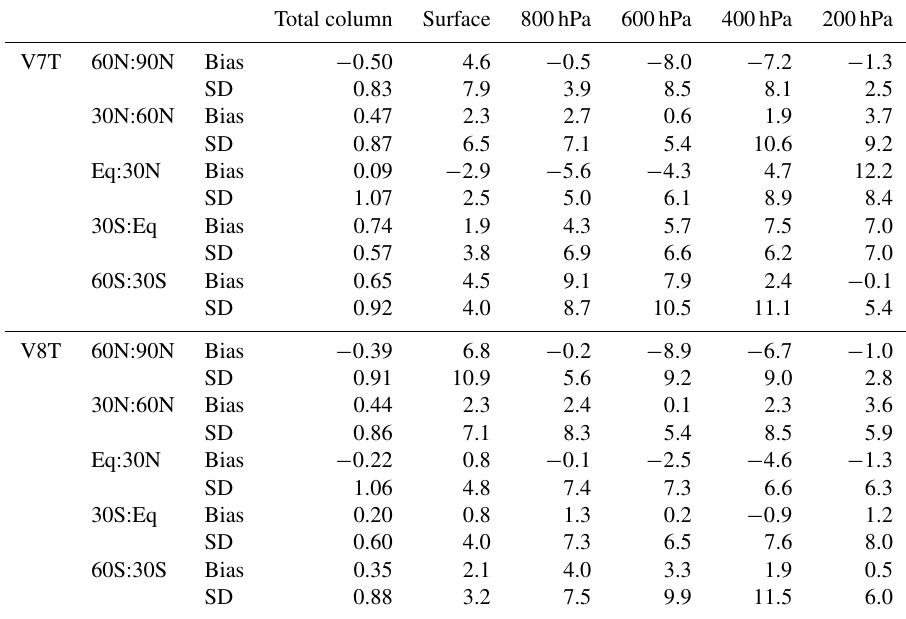
Table 4. Latitude dependence of validation results for V7 and V8 TIR-only products as indicated using in situ data from the HIPPO field campaign and corresponding to results shown in Figs. 2 and 6. See caption to Table 2.